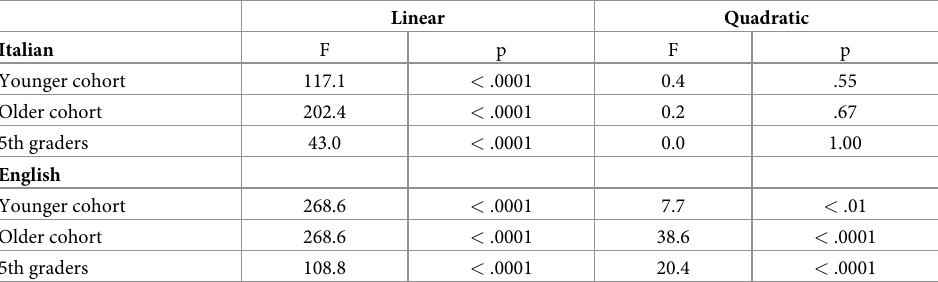
Table 2. Trend analyses on data of the lexical learning task. Younger cohort: Italian 2 nd grader and English 3 rd grad- ers. Older cohort Italian 4 th graders and English 5 th graders.